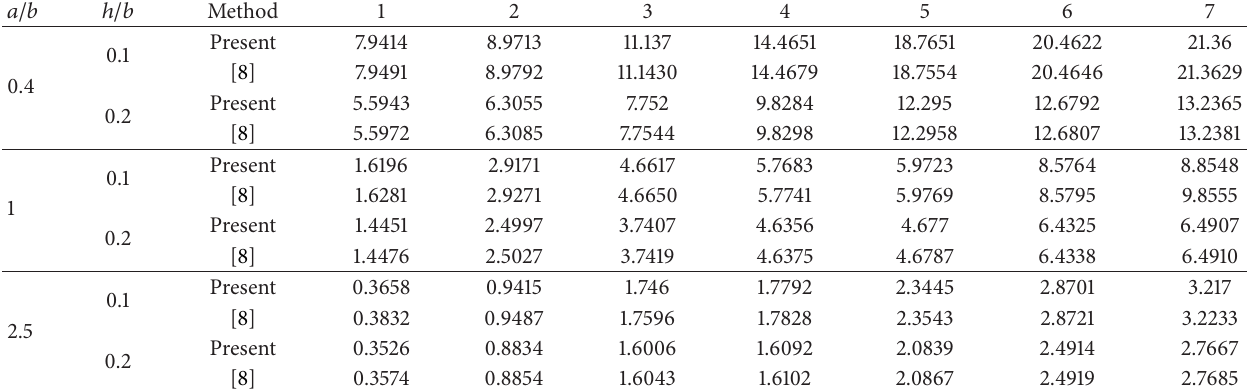
Table 5: The first seven frequency parameters Ω = ( 𝜔𝑏 2 / 𝜋 2 )( 𝜌ℎ/𝐷 ) 1/2 for C-S-S-F Mindlin rectangular plates. 𝑎/𝑏